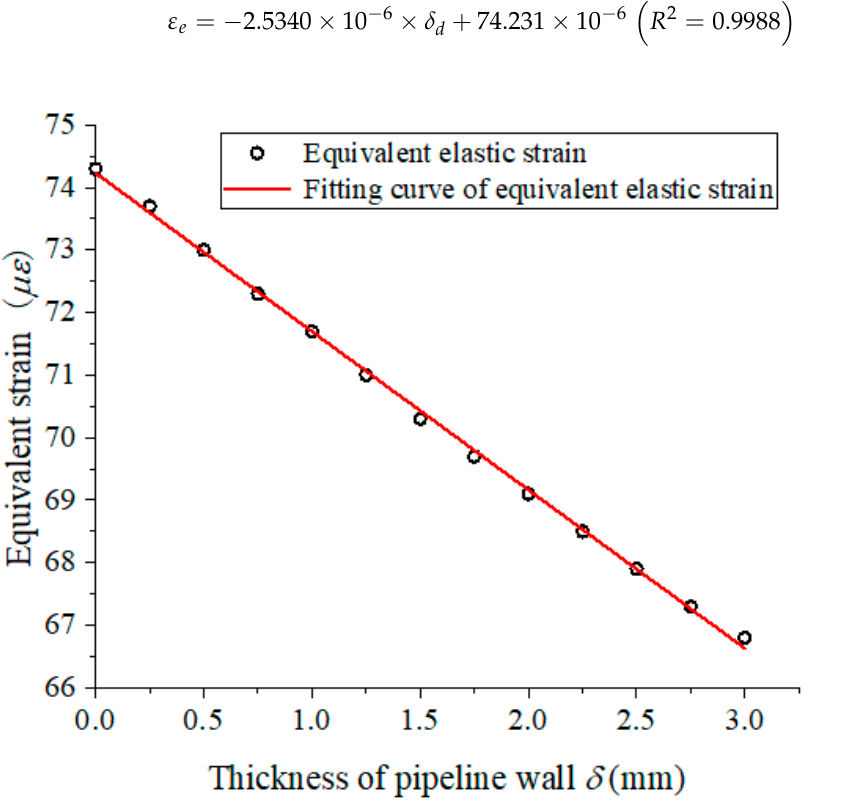
Figure 9. Strain along with the pipeline wall thickness variation.